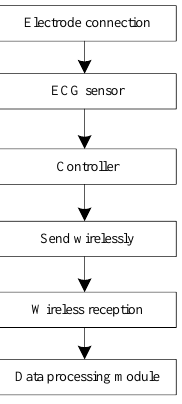
Figure 3. Structure diagram of ECG sensor